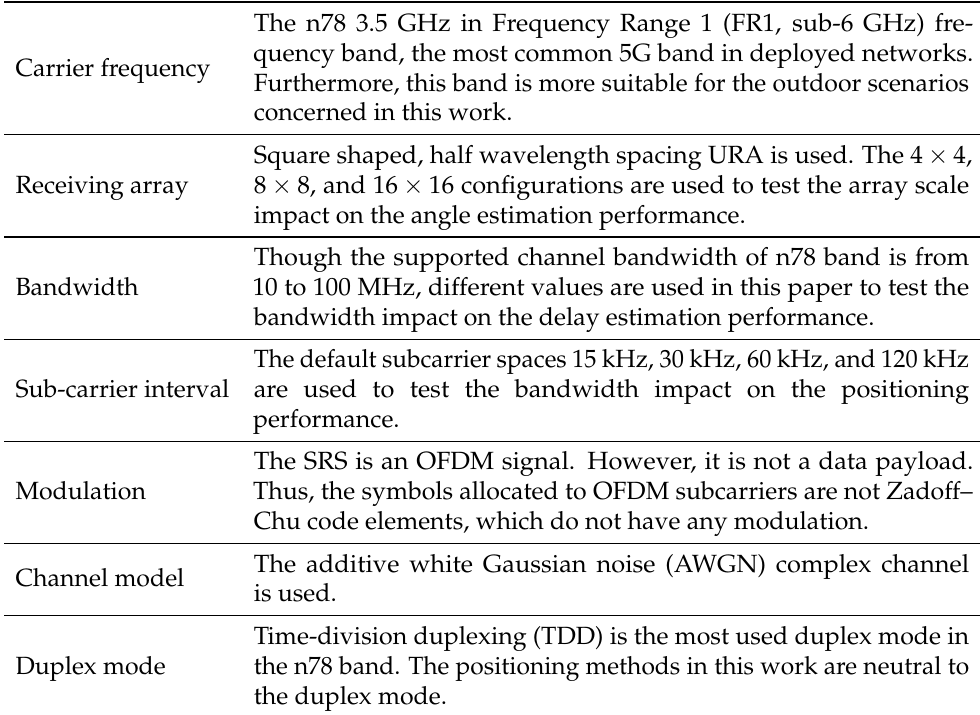
Table 1. System parameters.